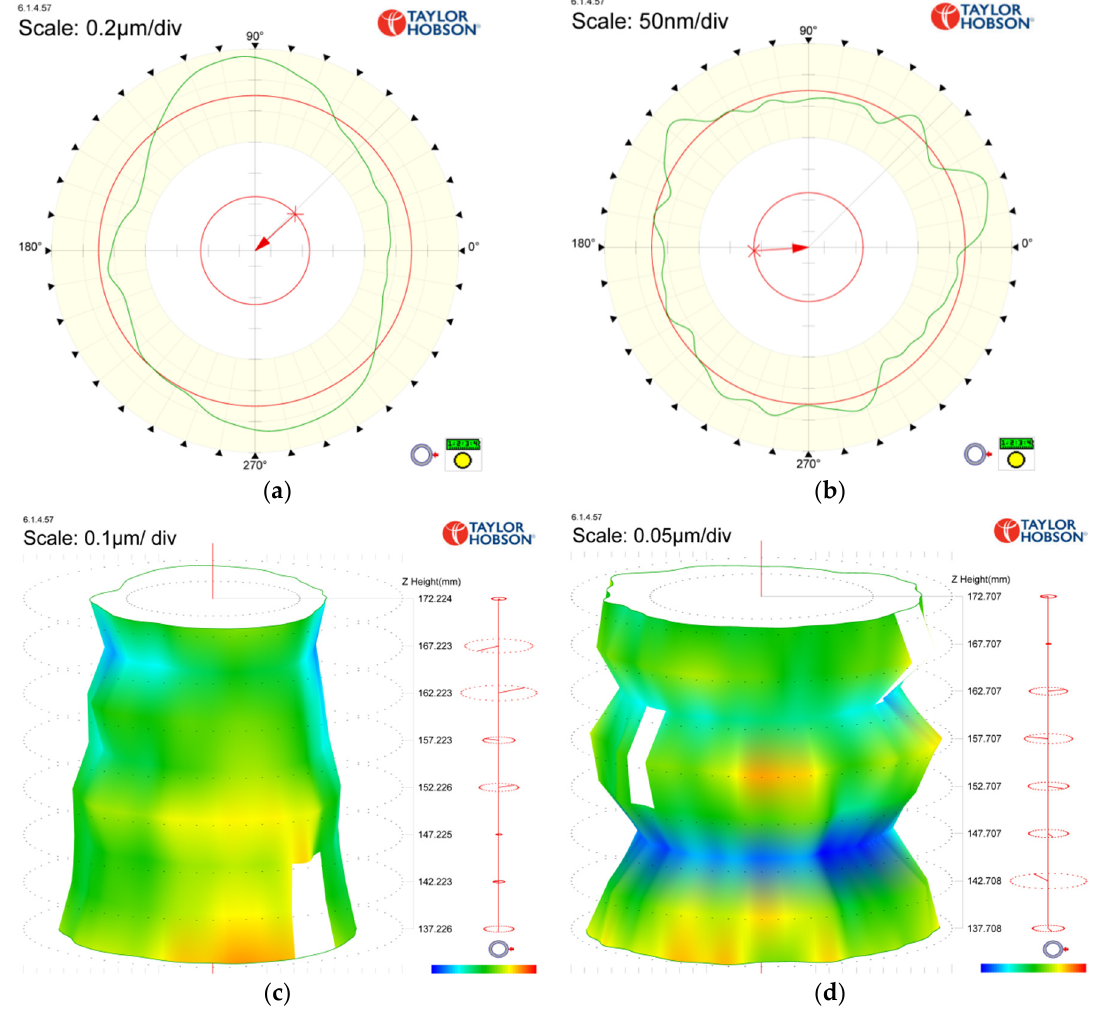
Figure 13. RONt and CYLt measurement results before and after machining: ( a ) RONt before machining in Section 6; ( b ) RONt after machining in Section 6; ( c ) CYLt before machining; ( d ) CYLt after machining.